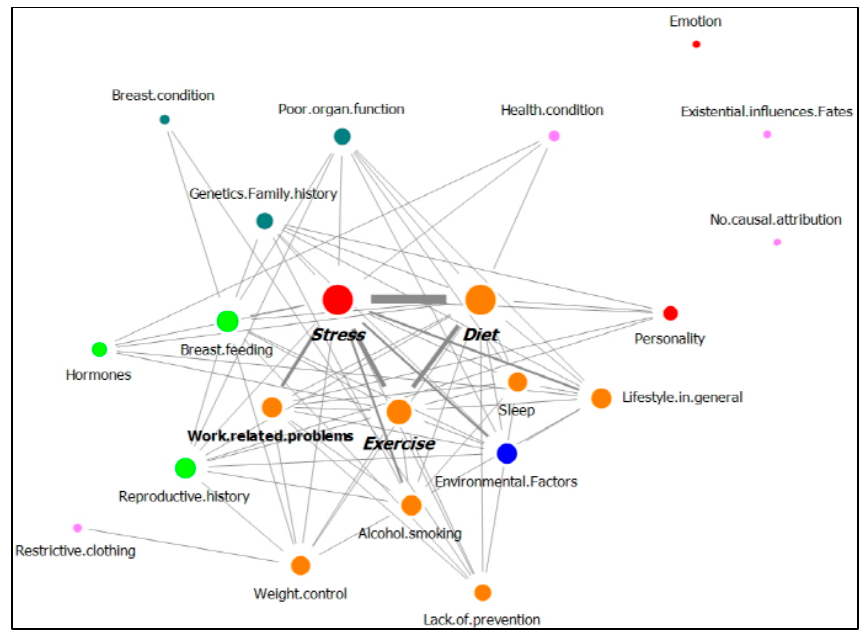
Figure 3. Network of causal attributions of breast cancer in patients with no family history of cancer (nodes of the same color mean that they belong to the same category.).